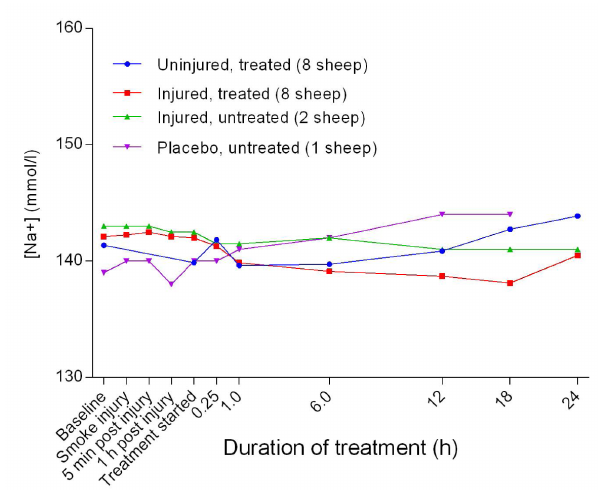
Figure 13. Concentration of sodium ions in blood (Mean ± SD) in smoke and non-smoke injured sheep that received extracorporeal life support as compared to that in untreated controls. Error bars have been omitted for clarity.